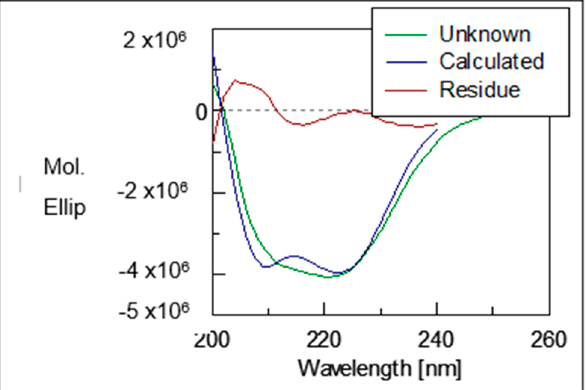
Figure 6. Diagram of CD spectrometry far-UV analysis. Two typical negative peaks can be seen at